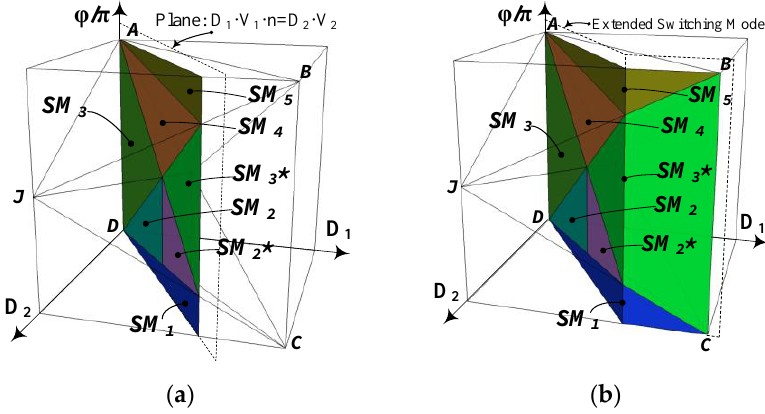
Figure 9. Case II. Non-depending on ϕ conditions: ( a ) Switching modes for D 1 ≤ d; and ( b ) Extended Switching Modes for D 1 > d.